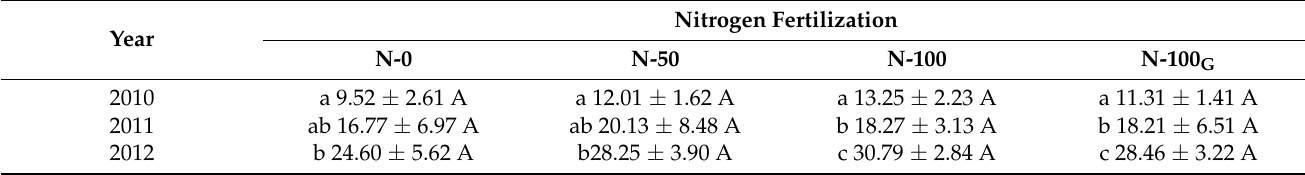
Table 4. Effect of year and nitrogen fertilization on yielding of apple trees, expressed in kg per tree − 1 ±